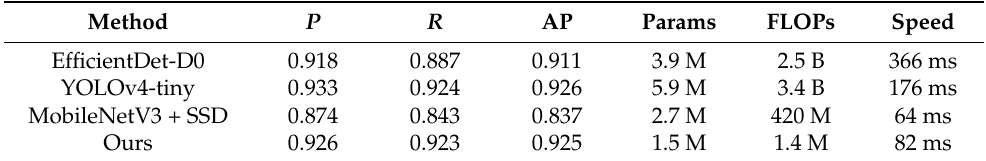
Table 6. Results of different detectors on DSSDD. Our method has a lightweight detector and can achieve comparable performance with CNN-based detectors.